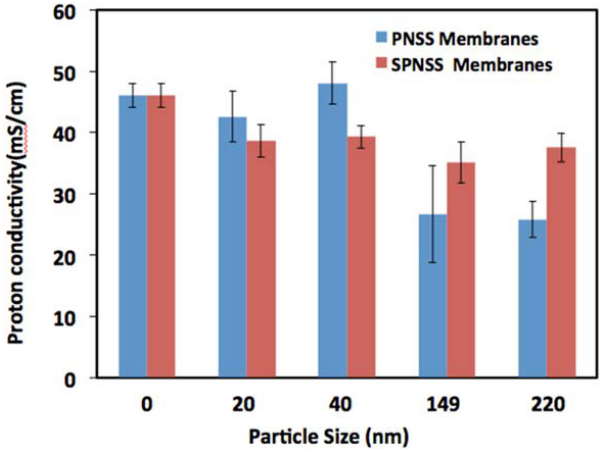
Figure 7. Comparison of proton conductivity of PNSS and SPNSS nanocomposite membranes at 120 °C and 50% relative humidity.